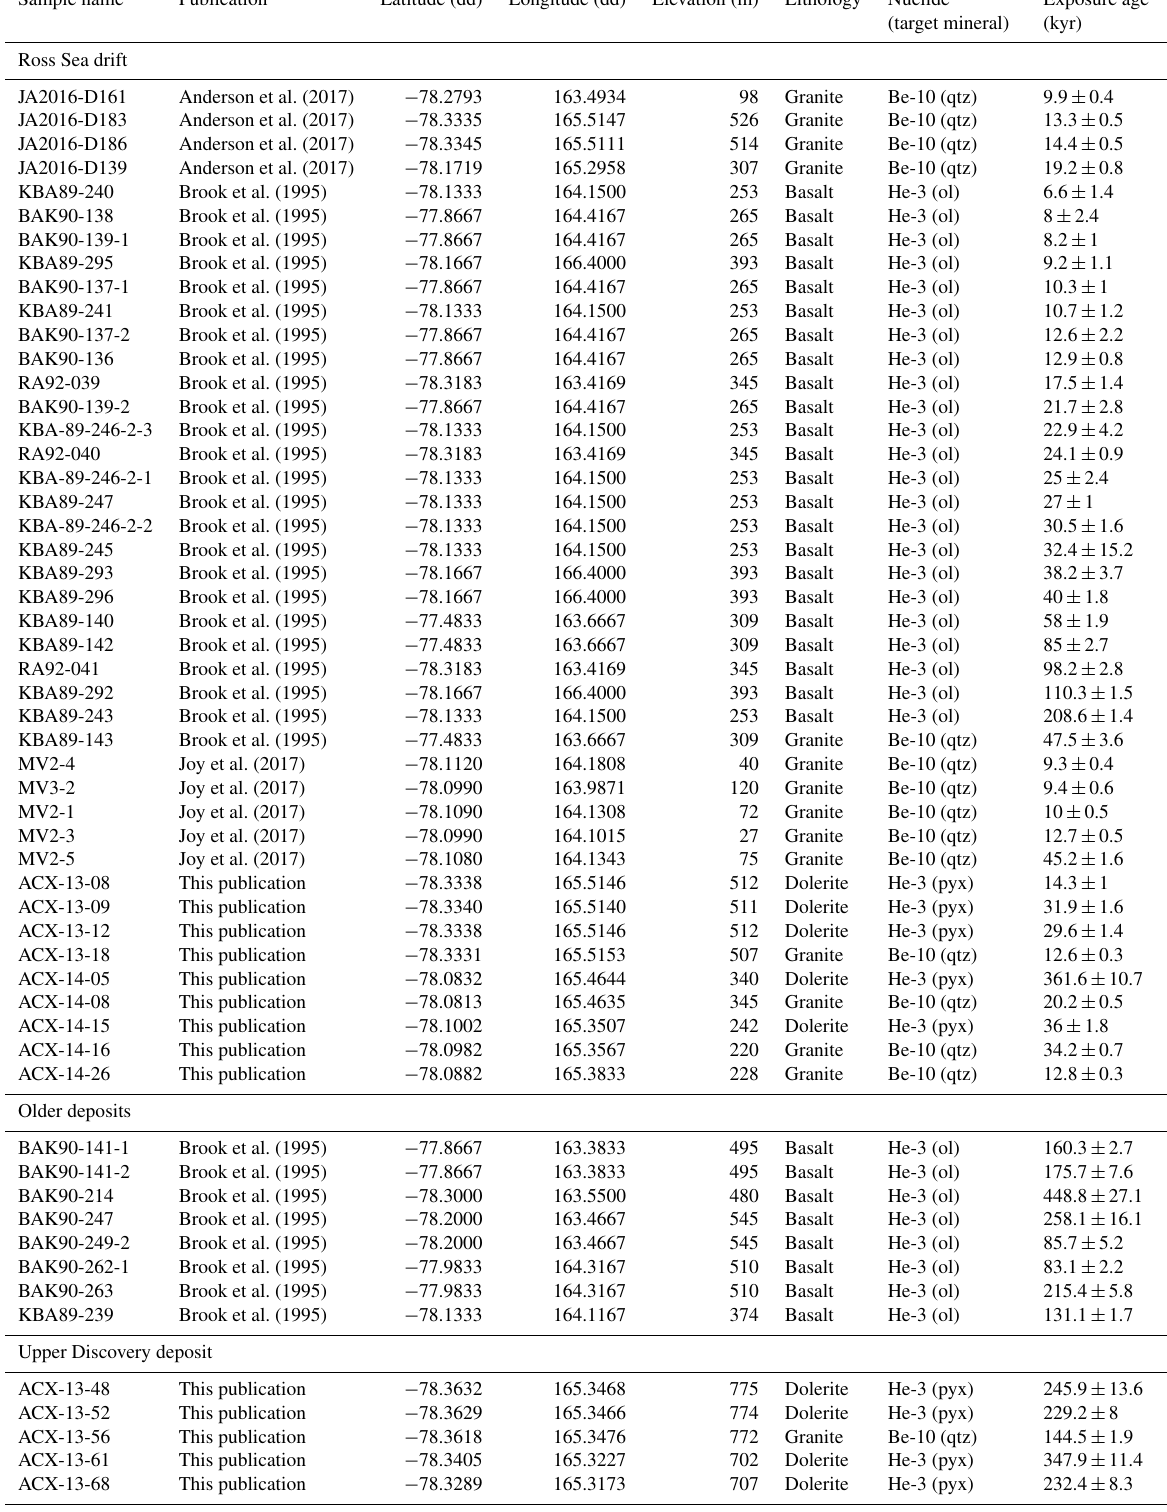
Table 4. Compiled exposure ages of glacial deposits in the McMurdo Sound